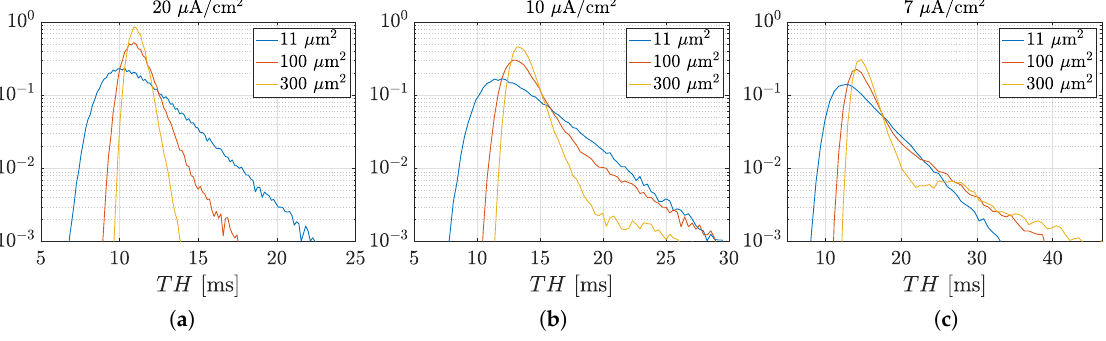
Figure 3. Probability densities f Θ ( TH ) for I 0 = (20, 10, 7) µA/cm 2 ; and patch = (11, 100, 300) µm 2 .